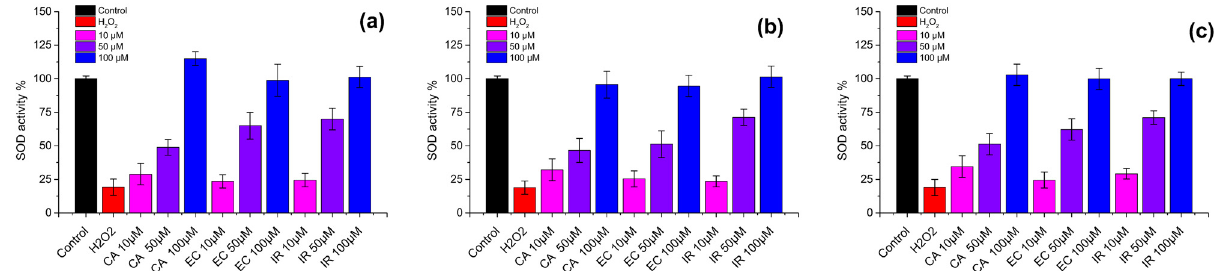
Figure 8: E ff ects of chlorogenic acid ( CA ) , echinacoside ( EC ) , and isorhamnetin - rutinoside ( IR ) on intracellular SOD levels of hydrogen peroxide - induced ( a ) LO2, ( b ) GES - 1, and ( c ) HUVEC cells.